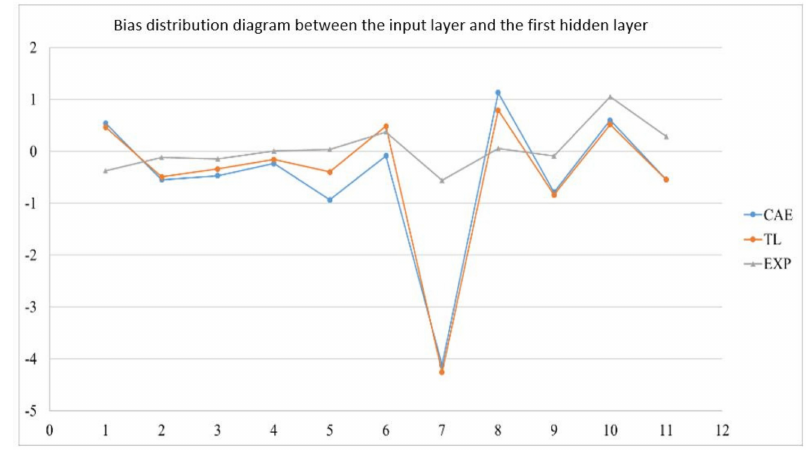
Figure 21. Bias distribution diagram between the input layer and the first hidden layer.